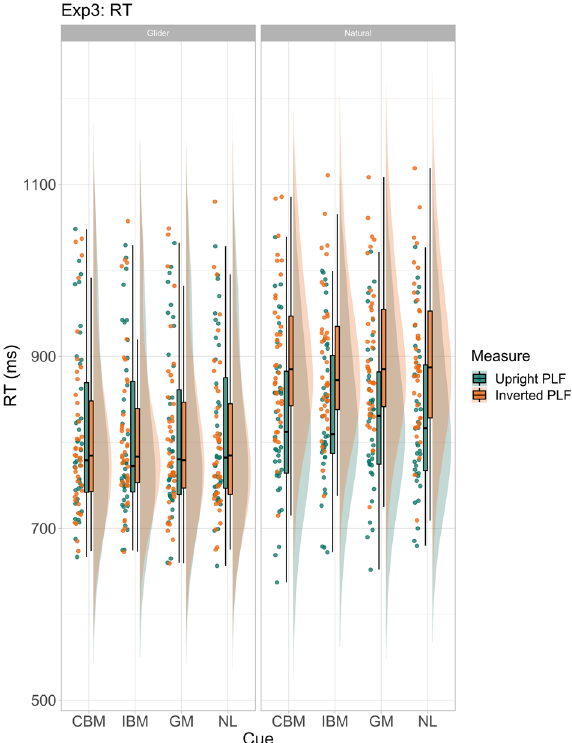
Figure 7. RTs (raw data) for glider and natural PLF motion conditions, for upright and inverted PLF orientation conditions for Experiment 3. Cue names are as follows: CBM congruent biological motion, IBM incongruent biological motion, GM general motion, NL no